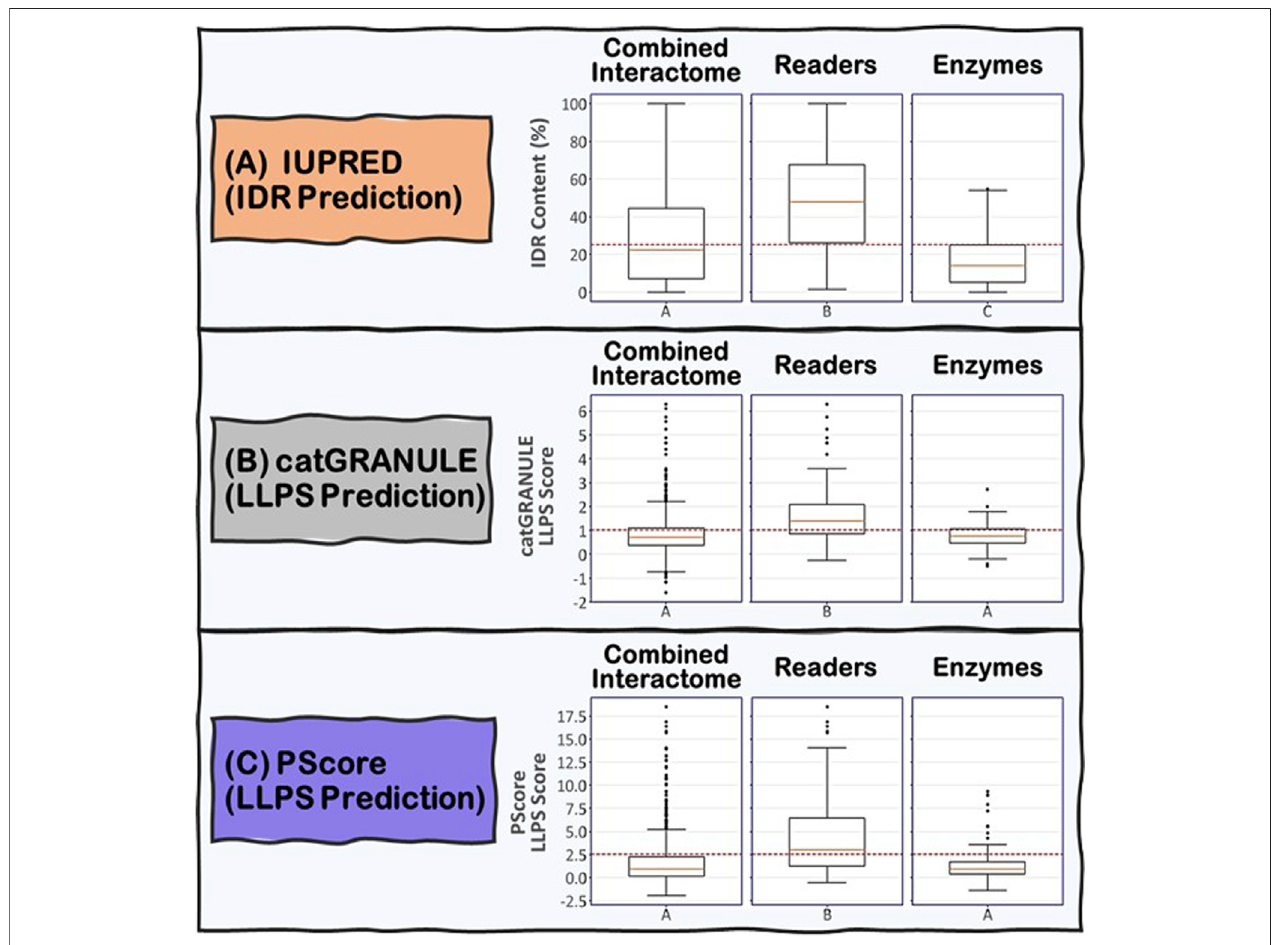
FIGURE 5 | Boxplots showing the distribution of (A) IDR content and (B) and (C) LLPS propensity predictions for the Combined Interactome, Readers and Enzymes used in this study. (A) IDR content predicted by IUPRED indicates that the three groups are signi fi cantly different ( p < 0.05) with the Readers possessing the highest IDR content. (B) and (C) LLPS propensity predicted by catGRANULE and PScore indicate that the Readers are signi fi cantly different from the other two groups ( p < 0.05) possessing the highest LLPS propensity while Enzymes and Combined Interactome are not signi fi cantly different from each other ( p < 0.05). The established critical threshold for each prediction is represented in dashed red line: (A) 25% IDR content, (B) 1.0 LLPS propensity score, (C) 2.5 LLPS propensity score. This critical threshold suggests whether a protein possesses (A) substantial IDR content and (B) and (C) potential to promote LLPS.